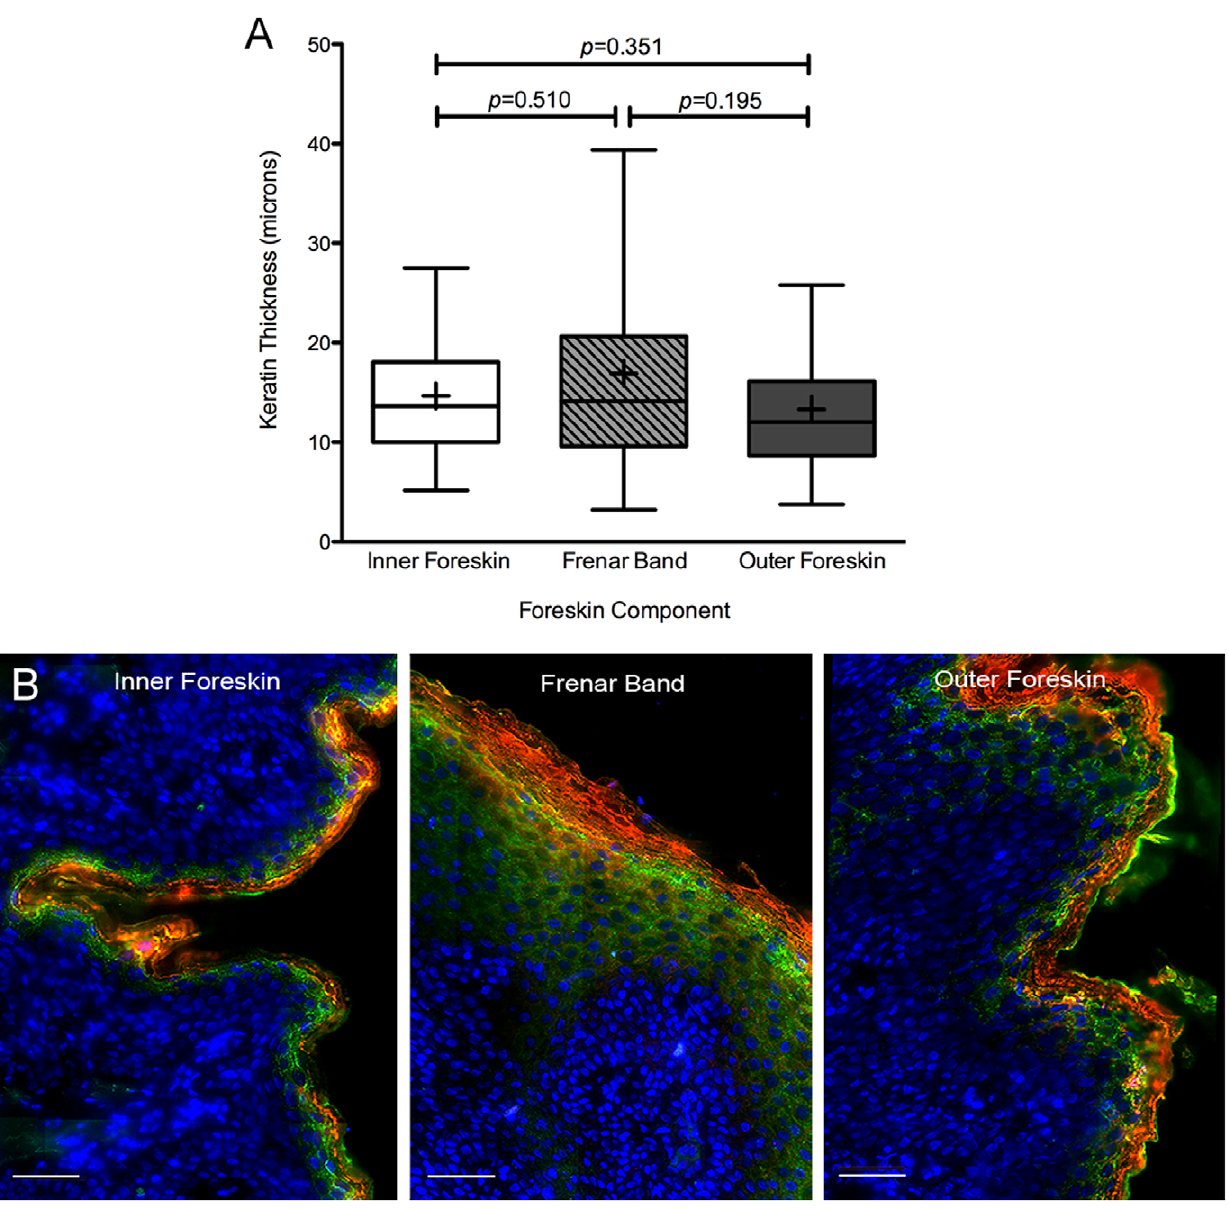
Figure 2. Cumulative foreskin keratin thicknesses by region. (A) Whisker and boxplots of cumulative keratin thicknesses per region: inner foreskin (white), frenar band (light gray), outer foreskin (dark gray). Median = middle line, mean = ‘ + ’ symbol, outliers not shown for ease of viewing. (B) Representative tissue from each region stained for filaggrin (red), involucrin (green), and cell nuclei (blue). White scale bars=50 m m.